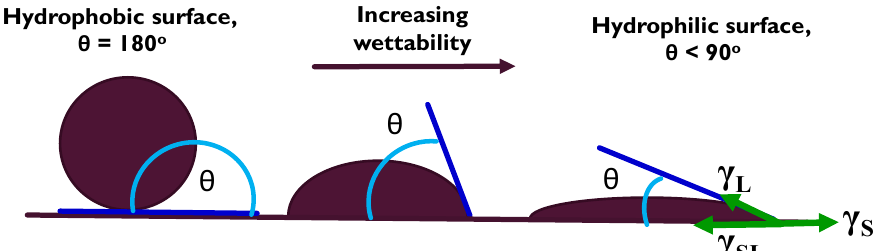
Figure 1. The wettability of a solid surface.